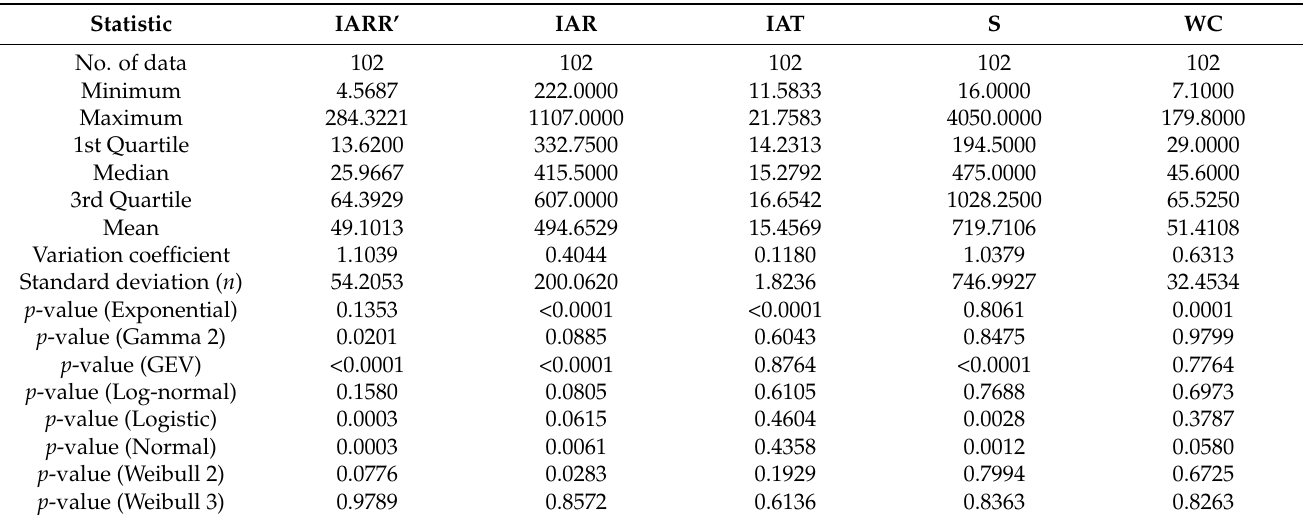
Table 2. Statistical description and data distribution analysis of a hydro-morphological dataset, obtained between 1967 and 2020 in northern Algeria.